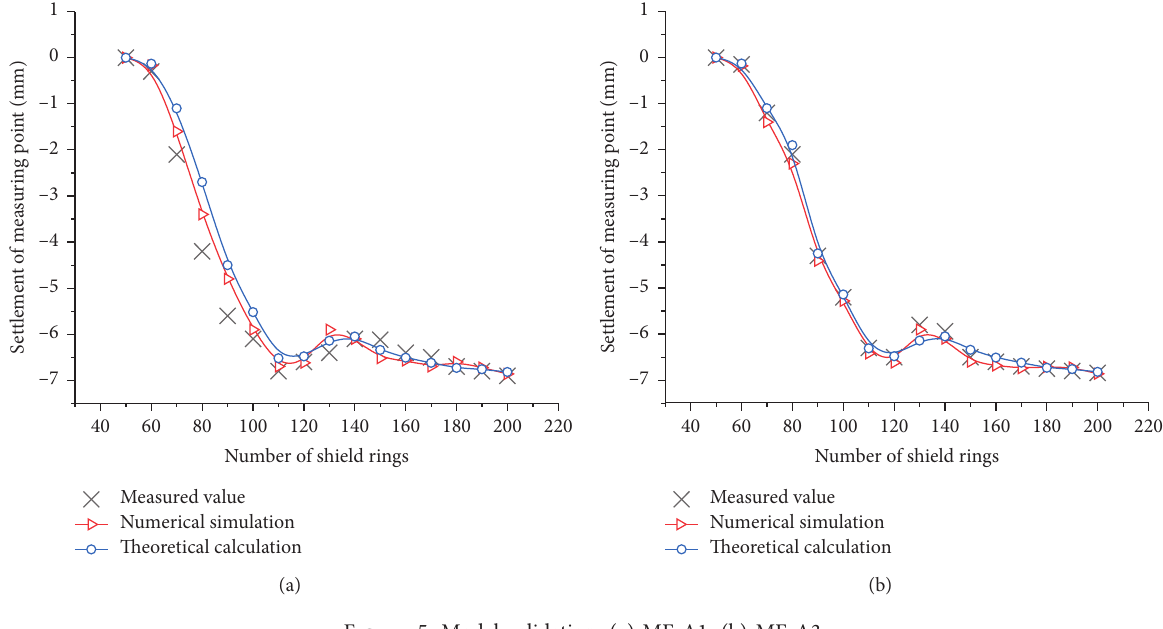
Figure 5: Model validation. (a) MF-A1. (b) MF-A3.